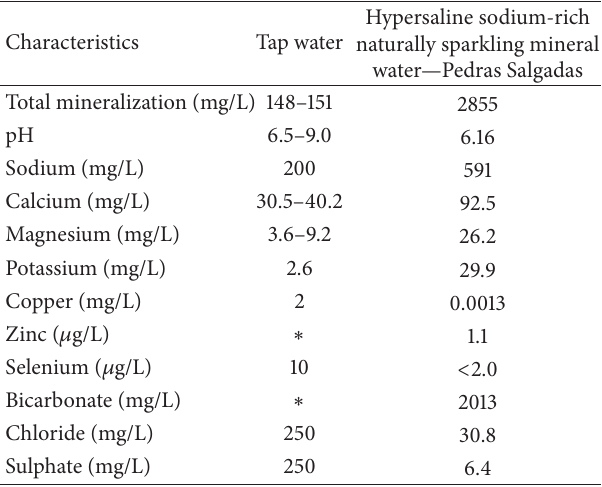
Table 1: Chemical characteristics of tap and natural mineral waters.